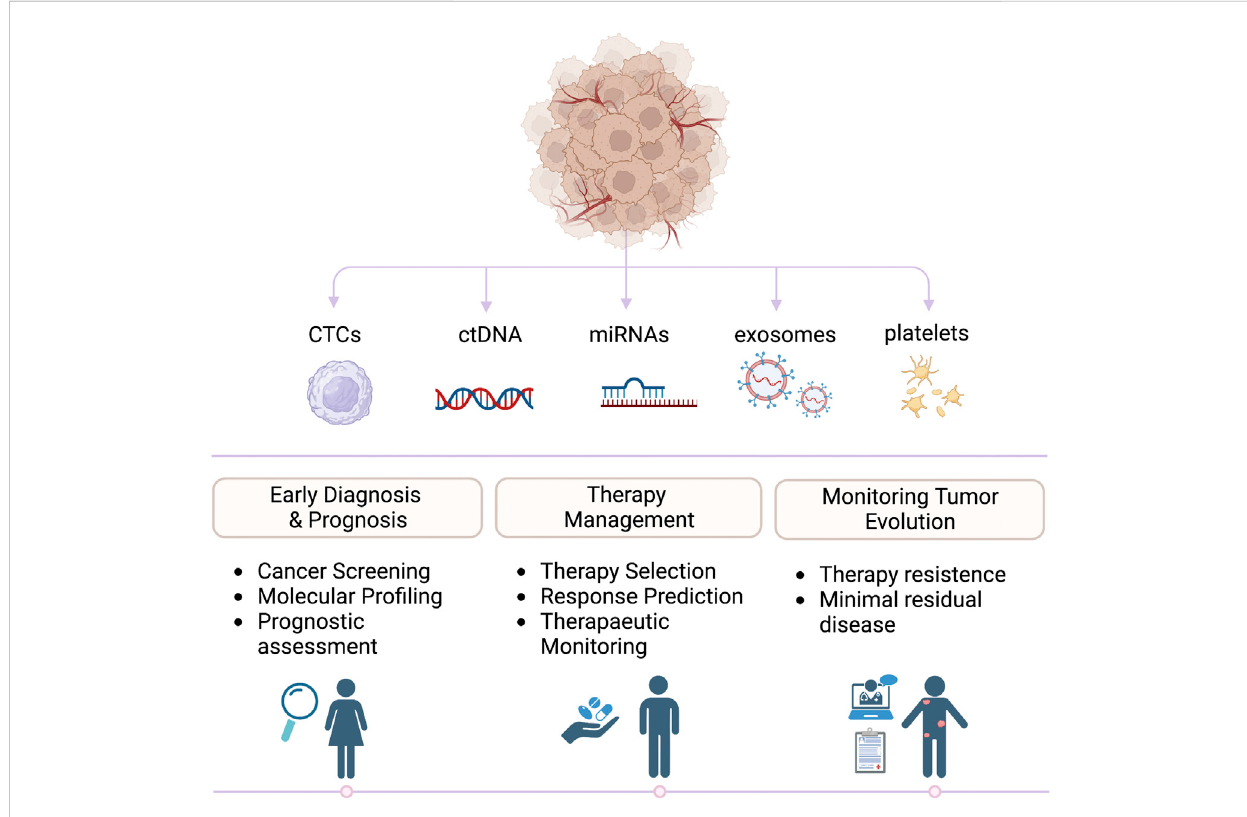
FIGURE 1 Clinical applications of liquid biopsies. Biomarkers released by primary tumors and metastasis can be detected in liquid biopsies and analyzed to guide prognosis, diagnosis, and treatments in oncologic patients.